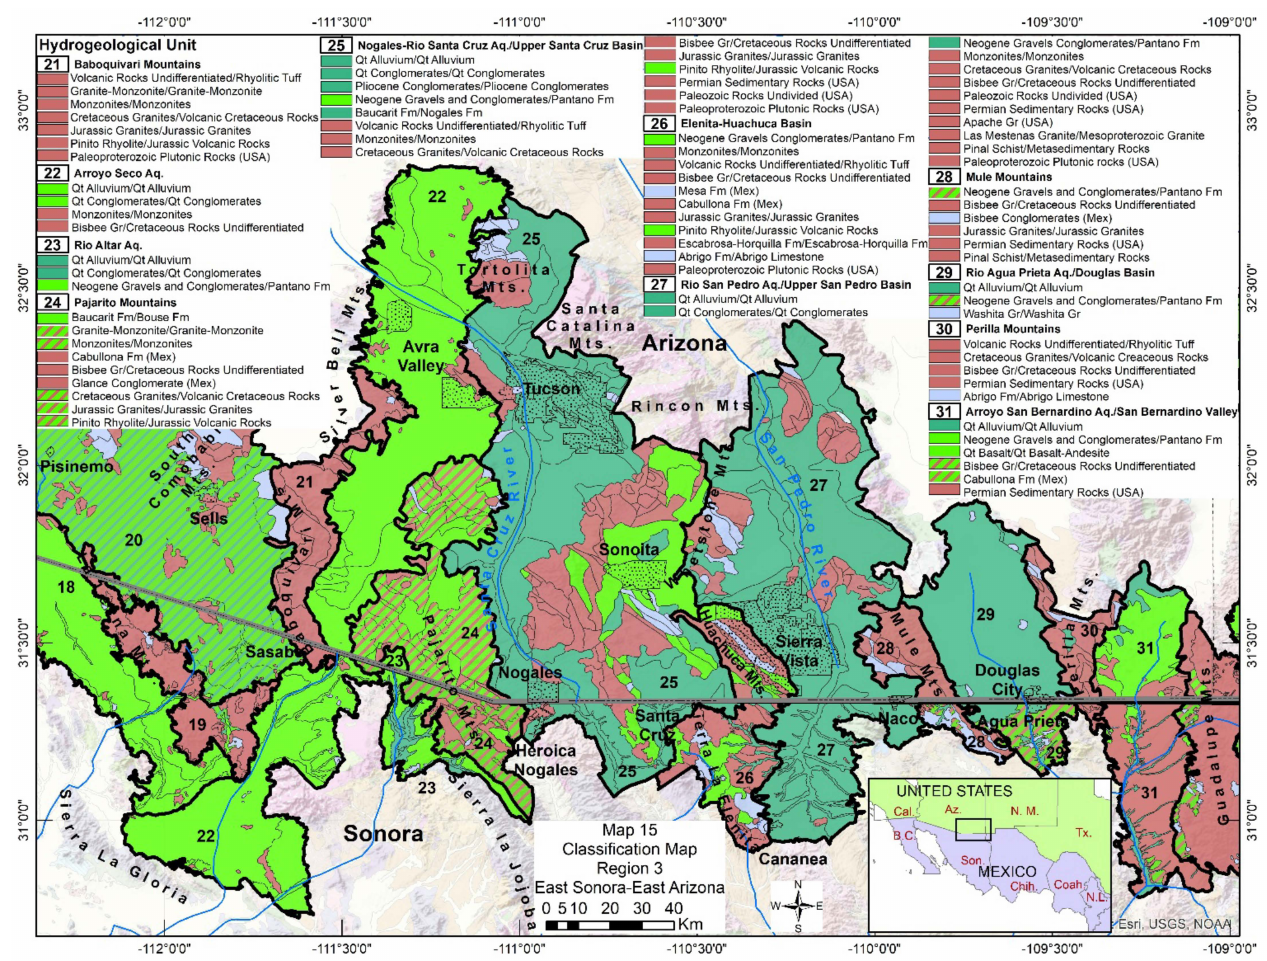
Figure 15. Classification map, East Sonora—East